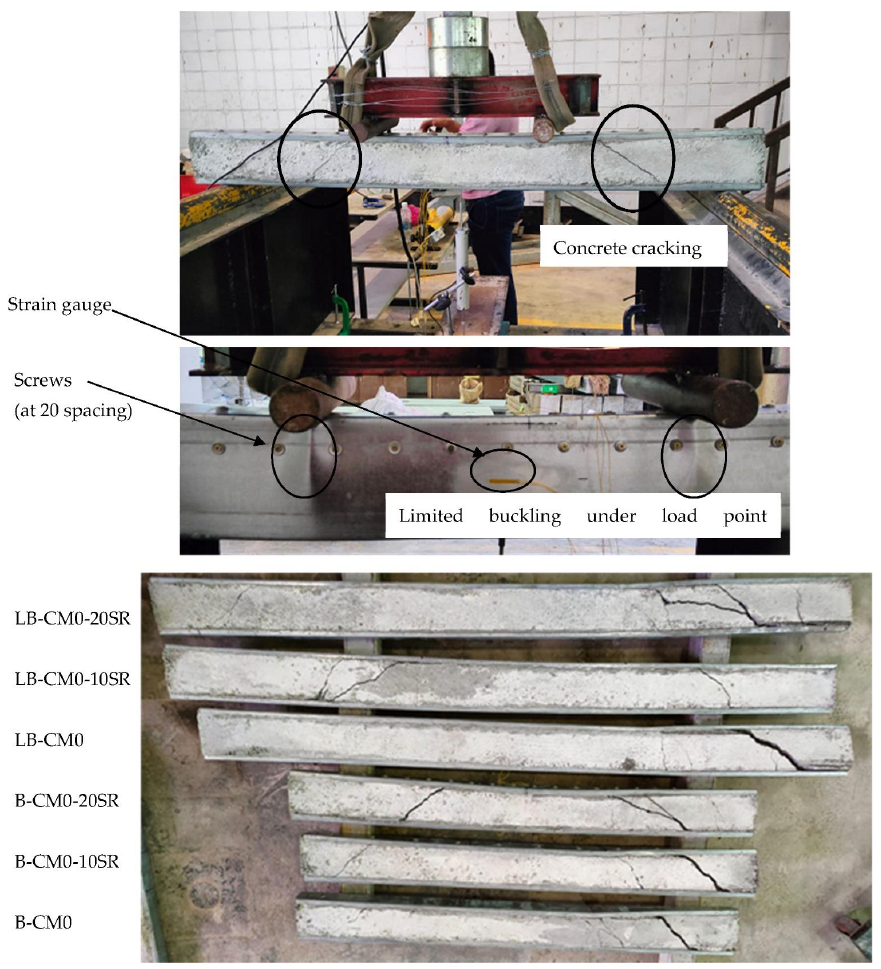
Figure 9. Typical failure modes of stiffened concrete filled specimens with screws.